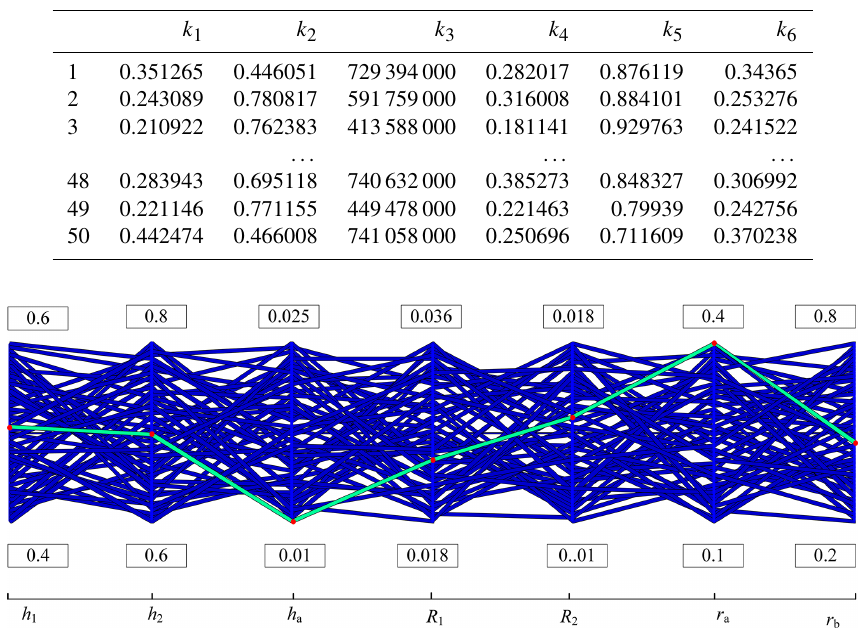
Table 3. Experiment design objective function value.